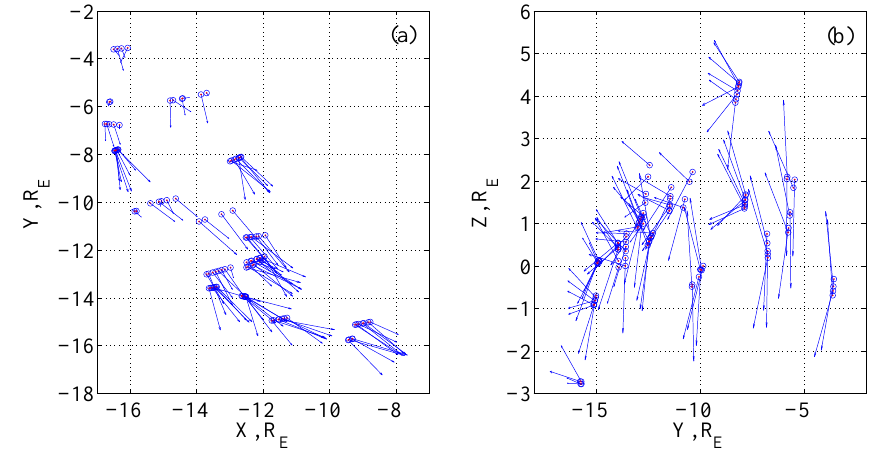
Figure 2. CS crossings (dots) and vectors N in the (X,Y) plane (a) and in the (Y,Z) plane (b) .